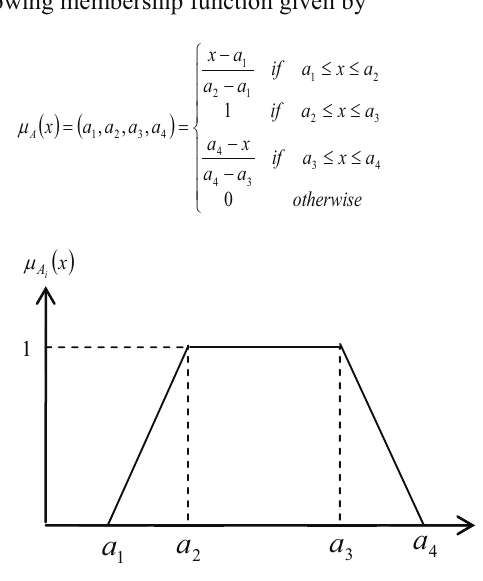
Fig 1: Trapezoidal Fuzzy Number